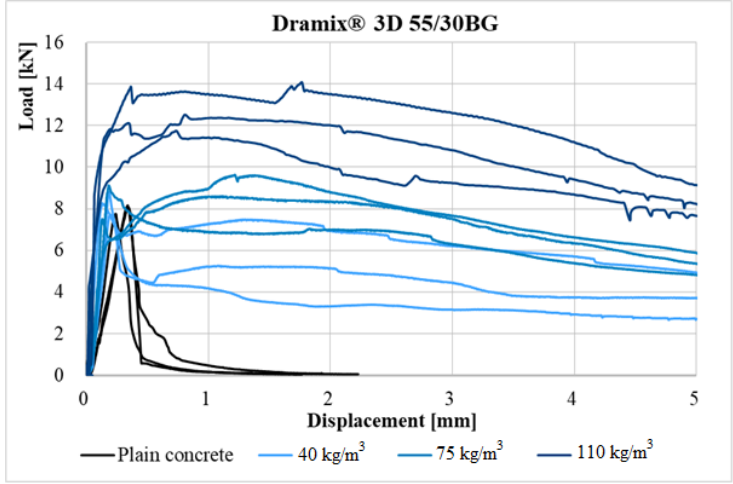
Figure 15. Load–displacement diagrams for plain concrete and fiber-reinforced concrete with fiber dosage of 110 kg/m 3 .